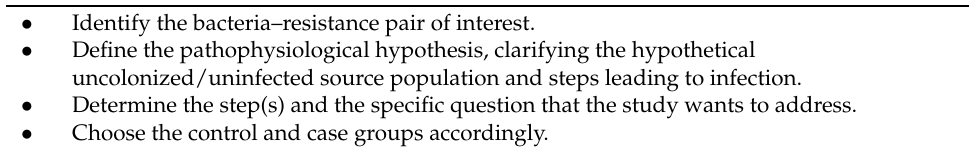
Table 1. Key points to design case–control studies evaluating antibiotic exposure as a risk factor of resistance in community-onset